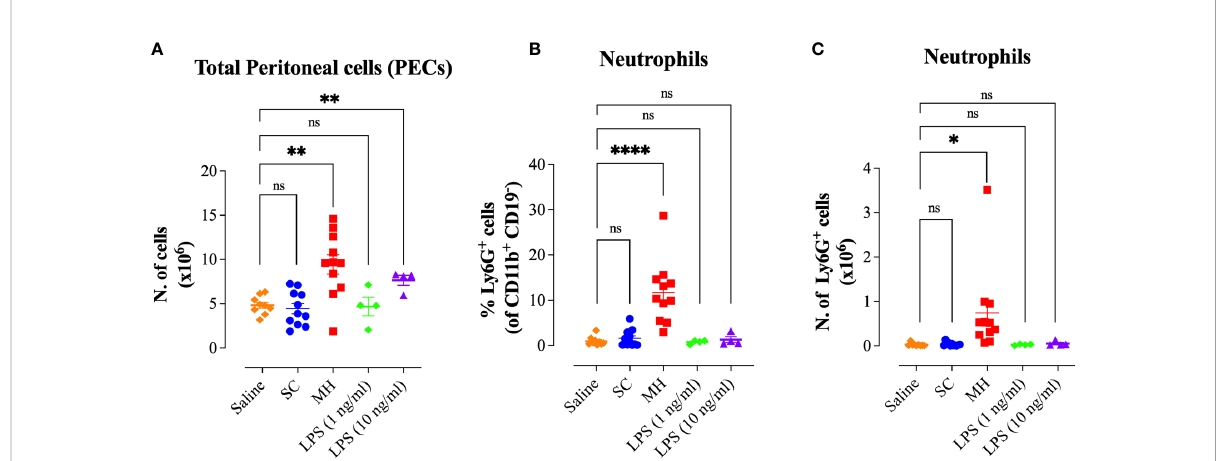
FIGURE 5 MH-induced peritoneal immune response is independent of its LPS content. (A) Total number of PECs following treatment with saline, 50% SC, 50% MH, 1 ng/ml LPS and 10 ng/ml LPS (B, C) Quanti fi cation of the percentage (B) and absolute number (C) of neutrophils (Ly6G + cells) in the peritoneal cavity of C57BL/6 mice following treatment with saline, 50% SC, 50% MH, LPS (1 ng/ml) and LPS (10 ng/ml). Asterisks denote statistically signi fi cant differences between the indicated experimental group and the saline-treated group.. The values for individual mice in a group (and mean ± SEM) are shown (Saline: n= 9, SC-treated: n=11; MH-treated: n=11, LPS (1 ng/ml): n= 4, LPS (10 ng/ml): n=4), pooled from 3 individual experiments. p values were calculated using the unpaired Student ’ s t-test (ns; p > 0.05, *p ≤ 0.05, **p ≤ 0.01, ****p ≤